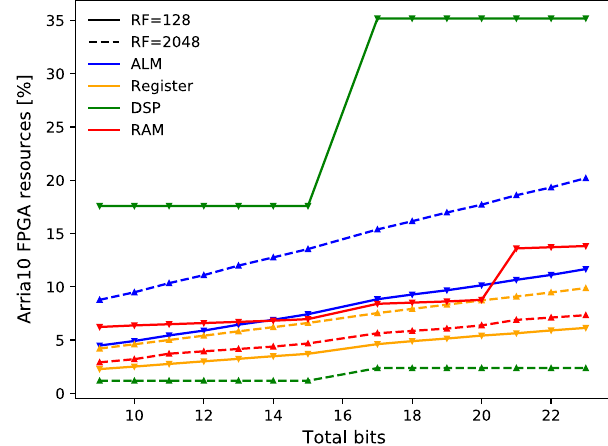
FIG. 10. FPGA resources required for the implementation of the DQN MLP are shown as a function of the fixed-point precision utilized for internal NN operations. All resources are normalized to the total available in a benchmark Arria 10 device (see Table IV). Results are shown for implementations with reuse factors of 128 (solid lines) and 2048 (dashed